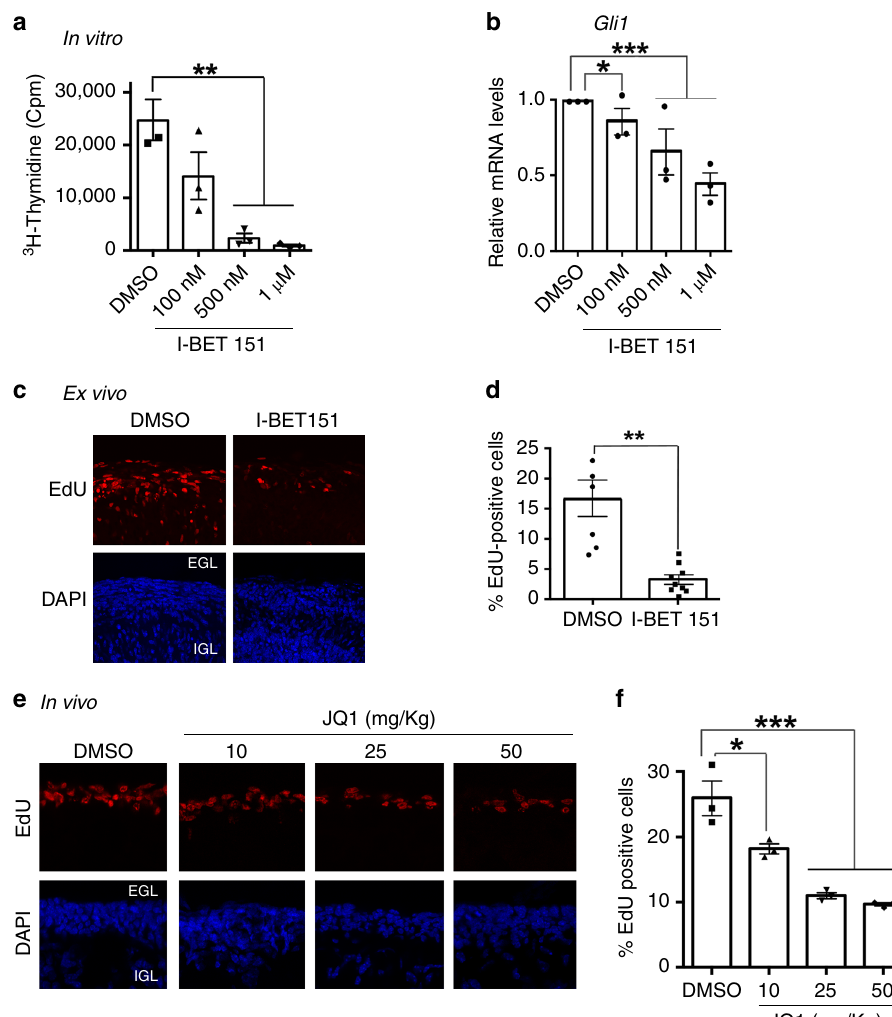
Fig. 4 BET bromodomain protein inhibition reduces Gli1 mRNA levels in puri fi ed GCPs and GCP proliferation in vitro, ex vivo, and in vivo. a BET protein inhibition reduces GCP proliferation in vitro. GCPs were puri fi ed from P6 mice and incubated with the indicated concentrations of I-BET151 or DMSO control for 24 h. Proliferation was then measured using a 3 H-thymidine incorporation assay. b BET protein inhibition reduces GCP Gli1 mRNA levels in vitro. Puri fi ed GCPs were incubated as described in a . qRT-PCR was performed and normalized to Gapdh . c Cerebellar organotypic slices were incubated in the presence of either DMSO or 1 μ M I-BET151 for 24 h, after which time EdU was added for 2 h. Images were then acquired with a confocal microscope and quanti fi ed using ImageJ. d Quanti fi cation of c . e Increasing doses of JQ1 yielded a gradual decrease in EdU incorporation in vivo in P8 pups. JQ1 was given to pups for 1 day at 10, 25, or 50 mg/kg every 12 h. Then EdU was injected subcutaneously 1 h prior to perfusion. f Quanti fi cation of e . The results are shown as the average values of three independent experiments and are represented as the mean ± SEM. A one-way ANOVA followed by Bonferroni multiple comparison testing ( a , b , f ) or a paired t test ( d ) was performed (* p < 0.05, ** p < 0.01, *** p < 0.001). Source data can be found in source data graphs